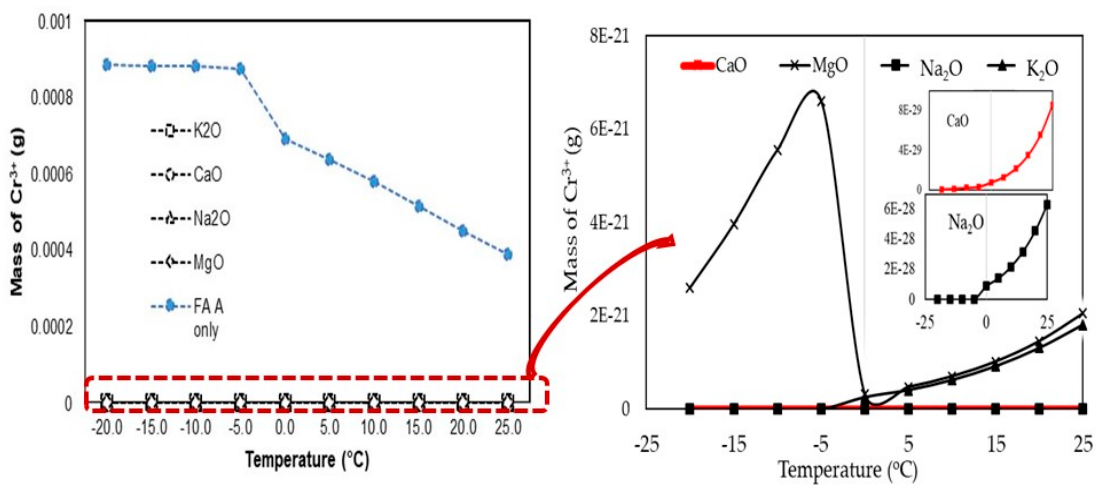
Figure 6. Mineral e ff ect on controlling Cr 3 + during leaching Figure 6. Mineral effect on controlling Cr 3+ during leaching process.